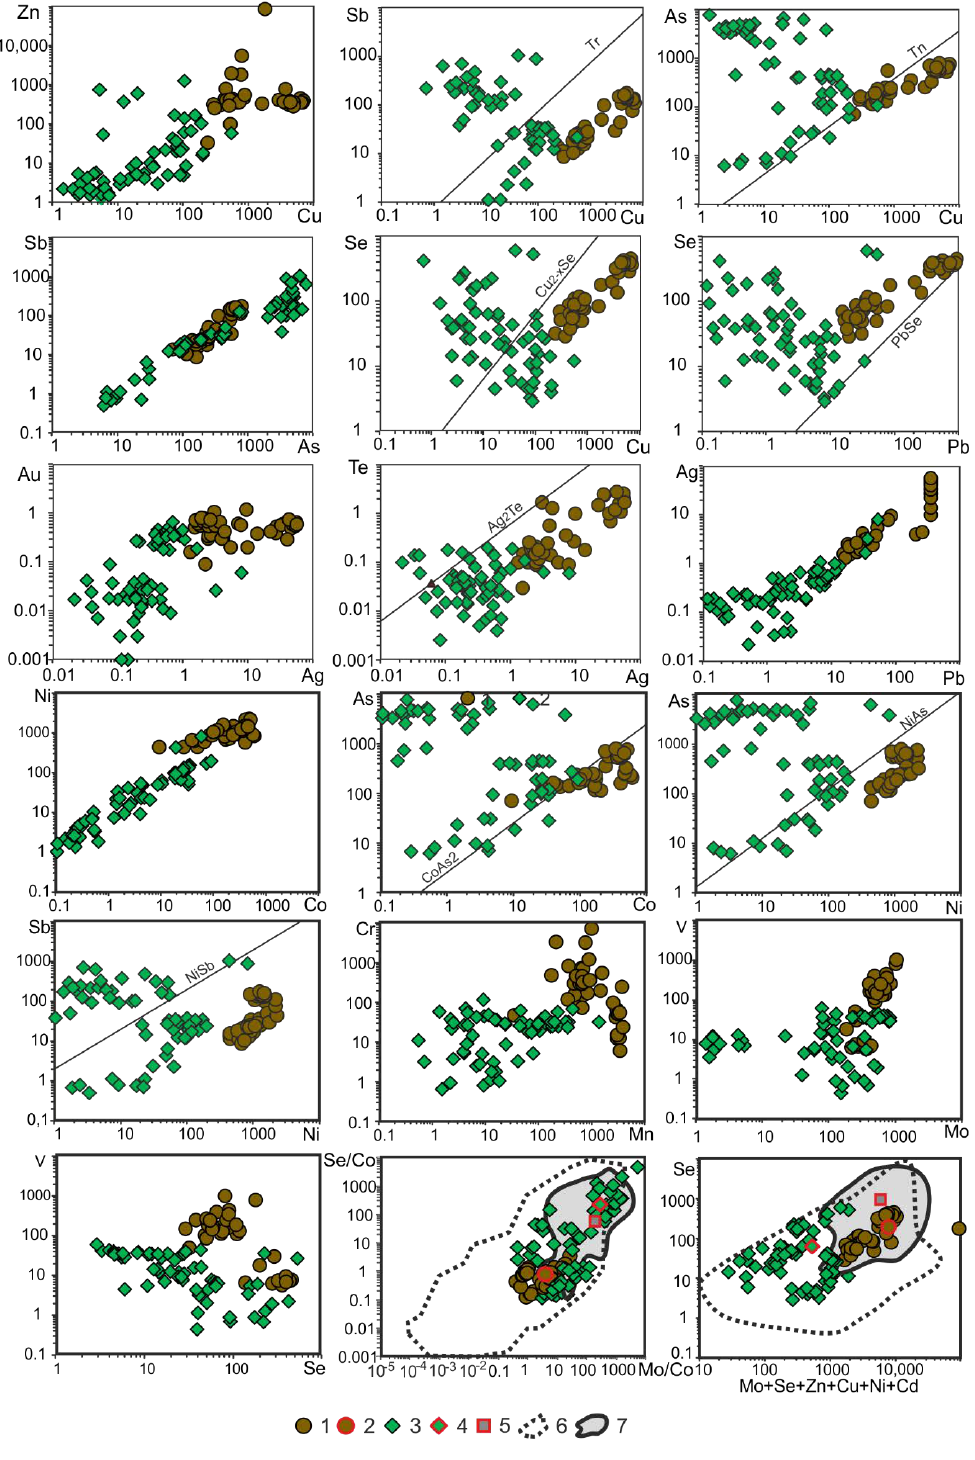
Figure 3. Distribution diagrams of trace element contents in framboidal (1) and nodular (3) varieties of pyrite from the Bazhenov Formation. (2, 4) average contents; (5) average contents in sedimentary–diagenetic pyrite according to [19]; (6) fields of pyrite from black shales, (7) fields of pyrite from high-metal black shales.